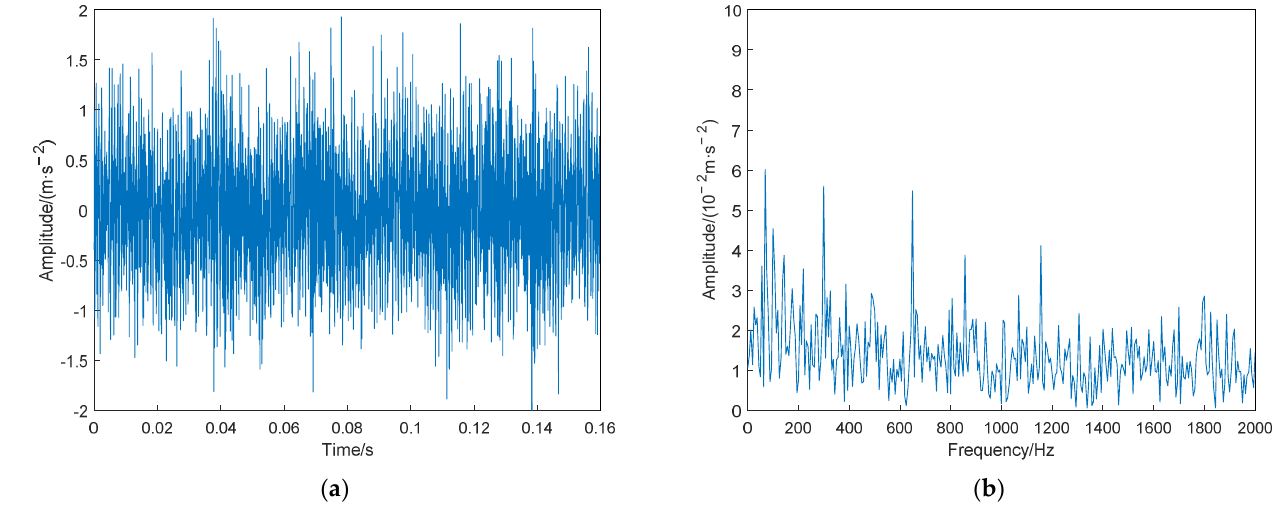
Figure 22. Time-domain waveform and envelope spectrum of fault signal: ( a ) fault signal time-do- main waveform; ( b ) envelope spectrum of the fault signal.